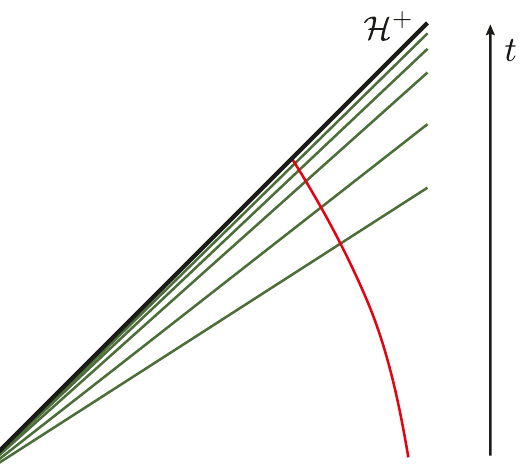
Figure 1 . Standard notions of PC duality are de(cid:12)ned in terms of near-horizon dynamics, using radial and time coordinates which remain outside the